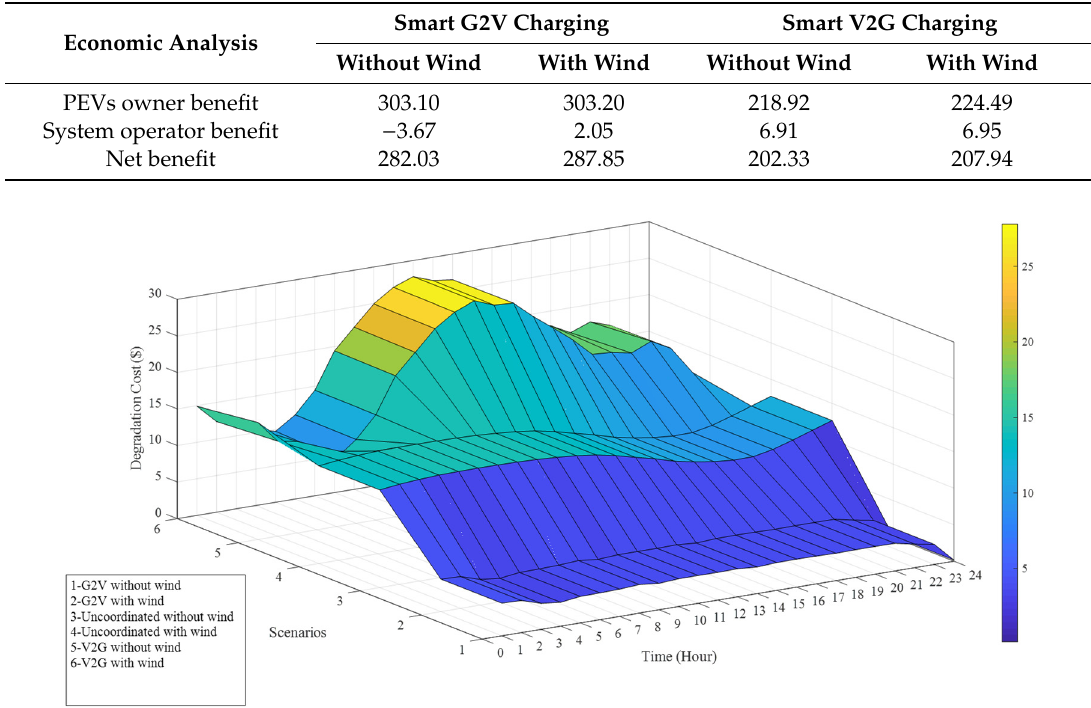
Figure 9. PEVs Battery Degradation Cost.